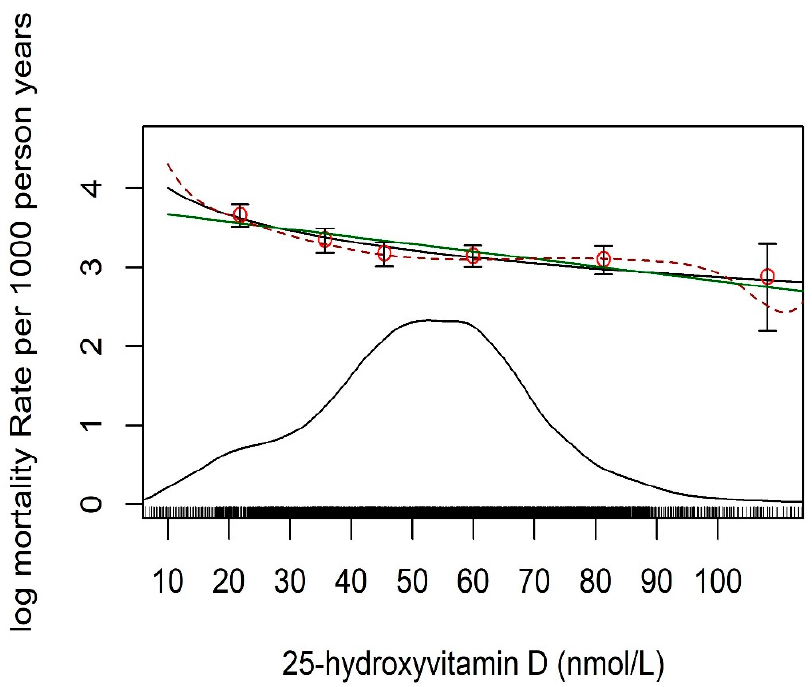
Figure 1. Mortality rate (log-scale) for 10 years from all causes by level of standardized 25-hydroxyvitamin D. A rug and density plot are superimposed to demonstrate where most of the 25(OH)D measurements lie. Fitted associations are shown as linear (green line), log-linear (black line), and spline (broken line).